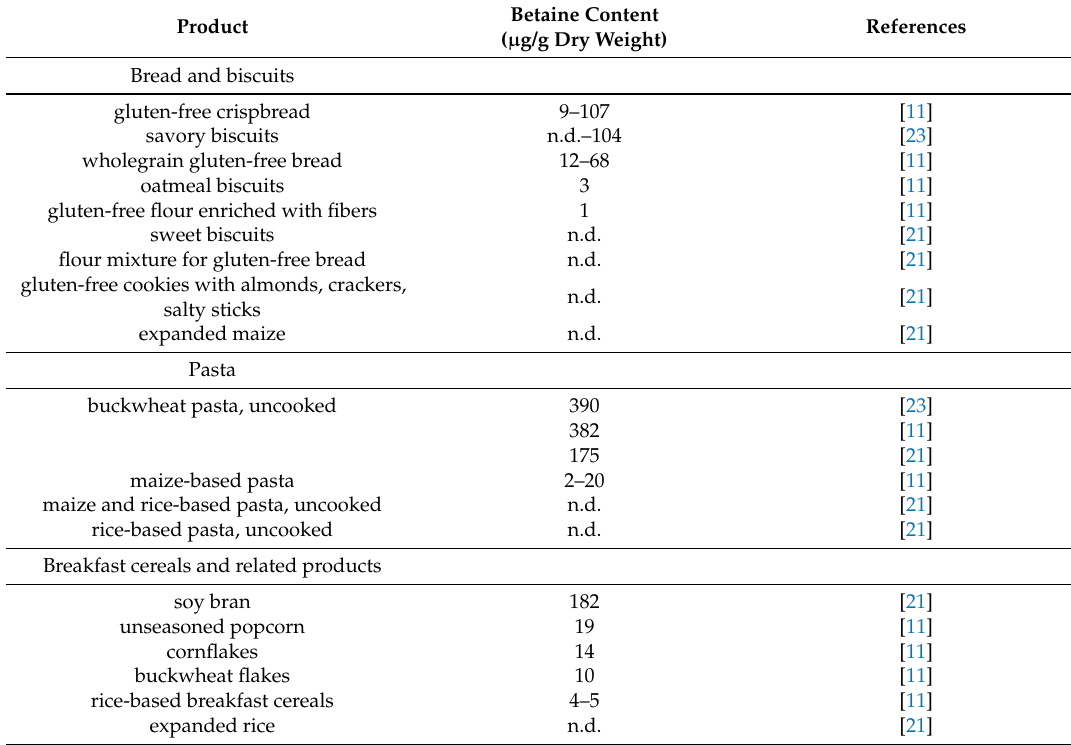
Table 3. Betaine content in gluten-free